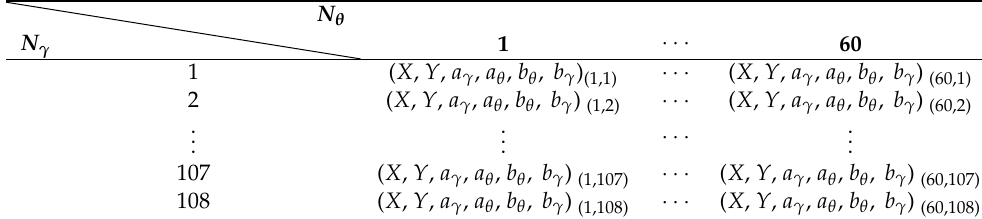
Table 4. Two arcminute interval linear coordinate